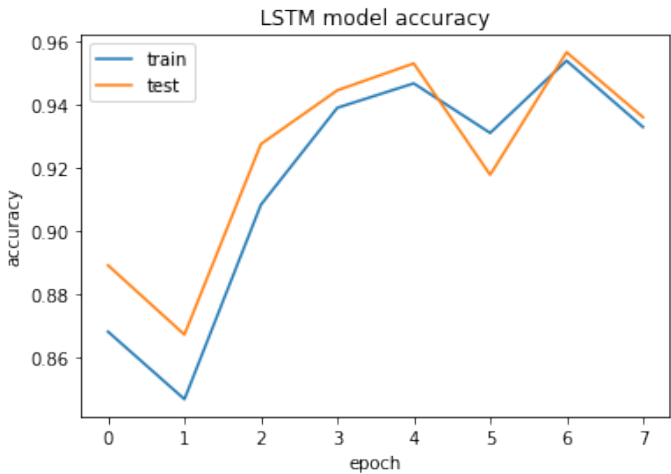
Figure 30. LSTM model accuracy.